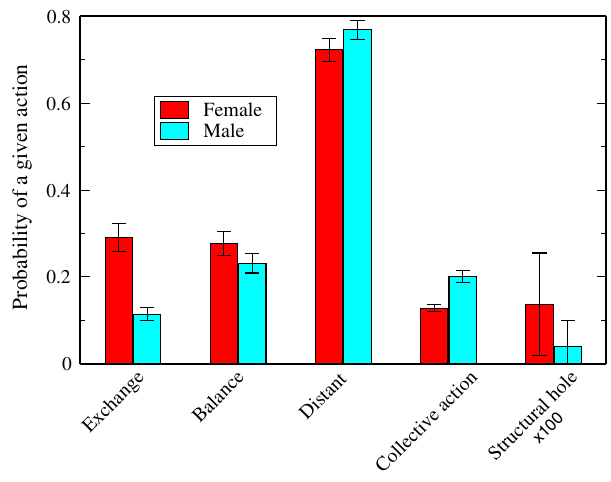
FIG. 3. Probability of different tendencies, based on self- reported gender in the QX community in favorites list interac- tions. Exchange and structural hole are significantly more frequent in females compared to males.